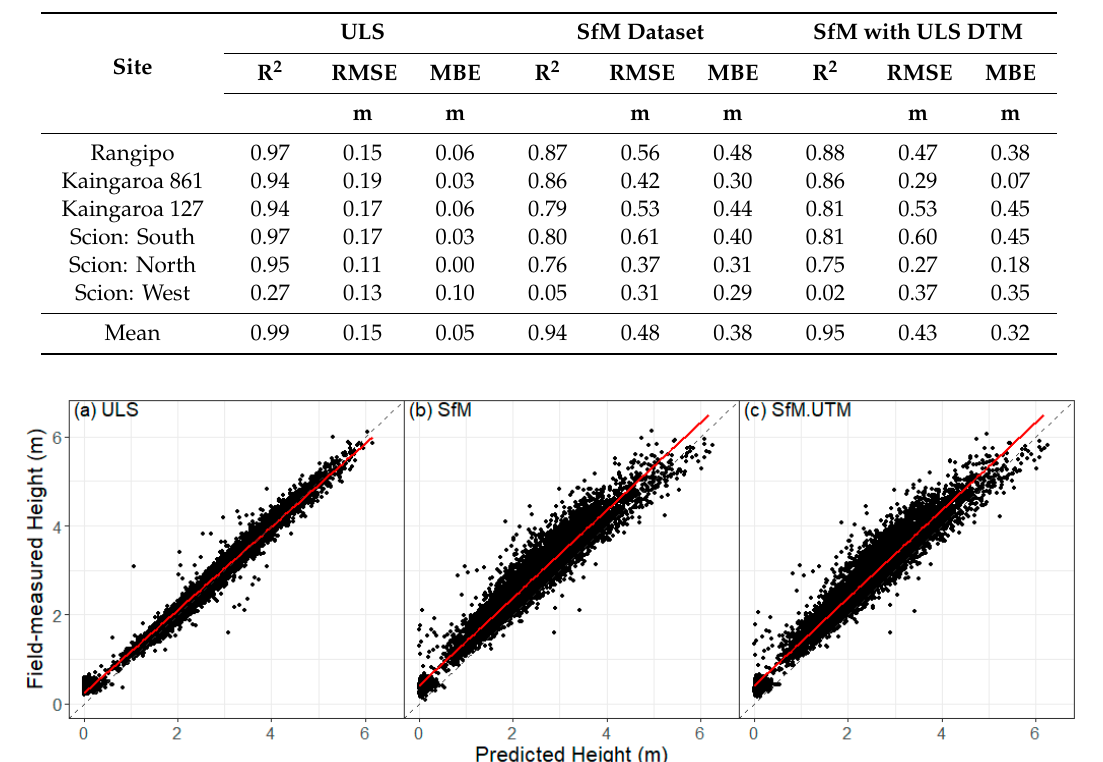
Table 3. Statistics describing the precision and bias of predictions of height using ULS, SfM and SfM that used a ULS DTM (SfM UTM ). Shown are the coefficient of determination, root mean square error (RMSE) and mean bias error (MBE).